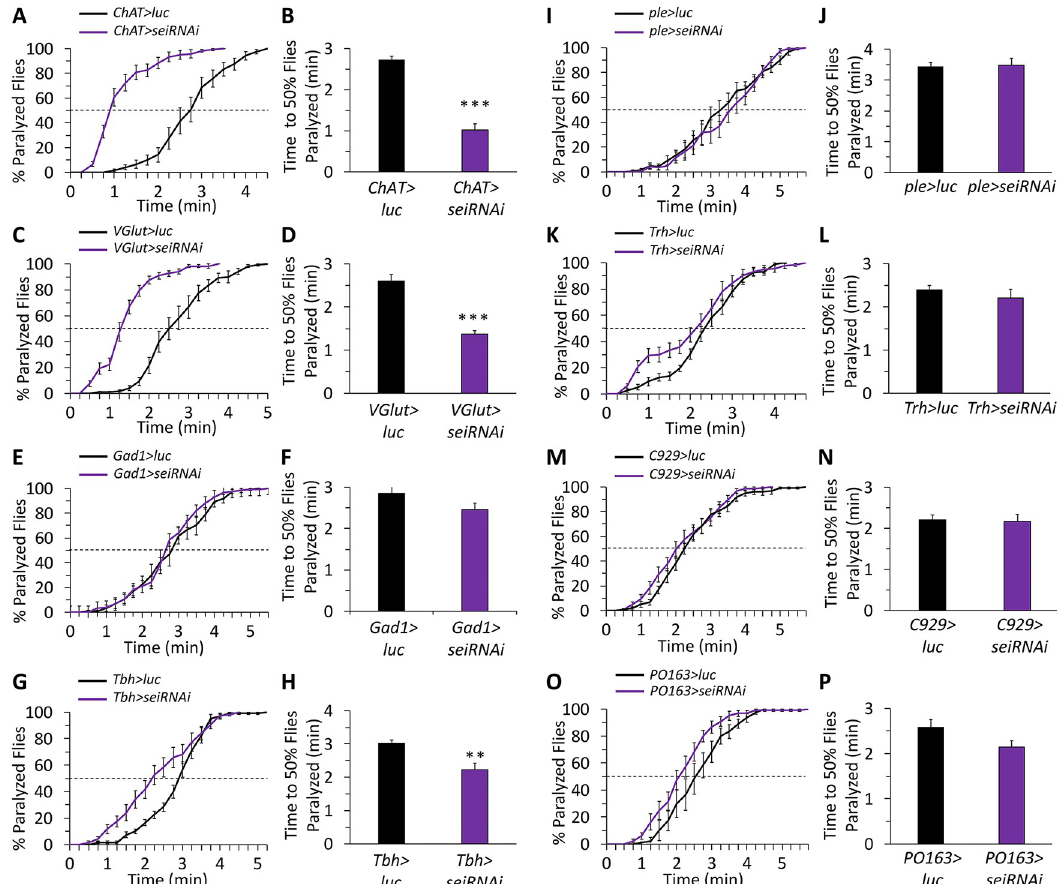
Fig 5. sei expression is specifically required in cholinergic, glutamatergic and octopaminergic neurons for response to acute heat stress. Neuronal subtype specific RNAi-dependent sei knockdown screen. A-B ) Cholinergic neurons ( ChAT-GAL4 ) n = 12 vials/genotype; C-D ) Glutamatergic neurons ( VGlut-GAL4 ) n = 6; E-F ) GABAergic neurons ( Gad1-GAL4 ) n = 12; G-H ) Octopaminergic neurons ( Tbh-GAL4 ) n = 12; I-J ) Dopaminergic neurons ( ple-GAL4 ) n = 12; K-L ) Serotonergic neurons ( Trh- GAL4 ) n = 12; M-N ) Peptidergic neurons ( C929-GAL4 ) n = 6; O-P ) Sensory neurons ( PO163-GAL4 ) n = 6. All experiments conducted with 10 flies per vial, placed in 41–42˚C water. Data are presented as mean ± SEM, �� p < 0.01, ��� p < 0.001 (Student’s t -